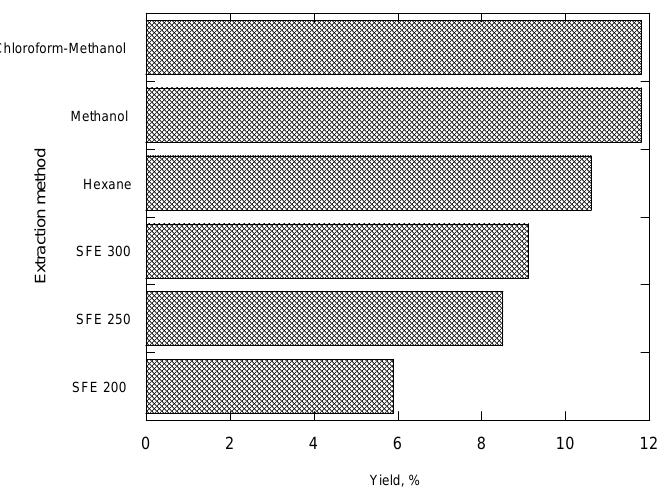
Figure 2. Effect of extraction method on the yield of wheat germ